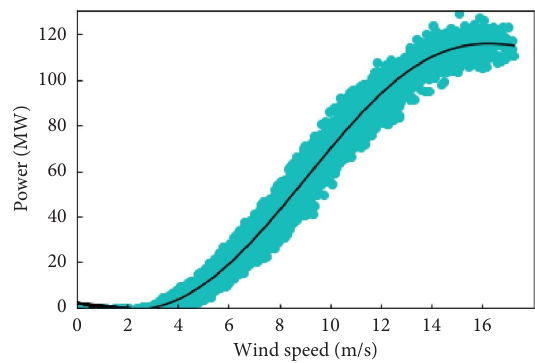
Figure 4: Wind speed-power